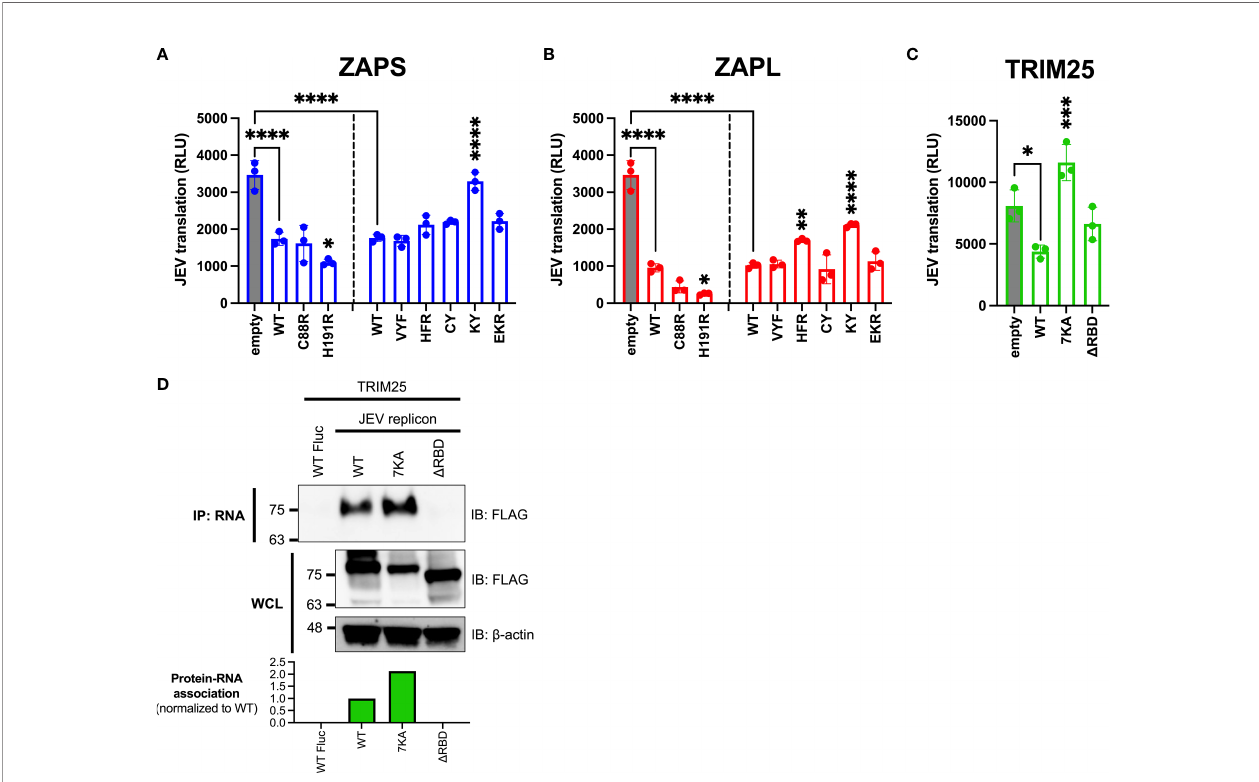
FIGURE 5 | Inhibition of JEV translation by ZAP and TRIM25 RNA binding mutants. (A, B) ZAP KO 293T cells or (C) TRIM25 KO 293T cells were transfected with (A) ZAPS RNA binding mutants, (B) ZAPL RNA binding mutants, or (C) TRIM25 RNA binding mutants, transfected with a replication-defective Japanese encephalitis virus (JEV) replicon RNA reporter, and lysed 4 hours post-reporter transfection for measurement of luciferase activity. Data from triplicate wells are representative of two independent experiments. Asterisks indicate statistically signi fi cant differences as compared to (A, B) ZAP WT or (C) TRIM25 WT within each subset of RNA binding mutants (by one-way ANOVA and Dunnett ’ s multiple comparisons test: *p < 0.05; **p < 0.01; ***p < 0.001; ****p < 0.0001). Unlabeled comparisons are not signi fi cant. (D) TRIM25 KO 293T cells were transfected with TRIM25 mutants. TRIM25 pulled down with RNA and in WCL were assayed by western blot. Blots were quanti fi ed with ImageJ. Data are representative of two independent